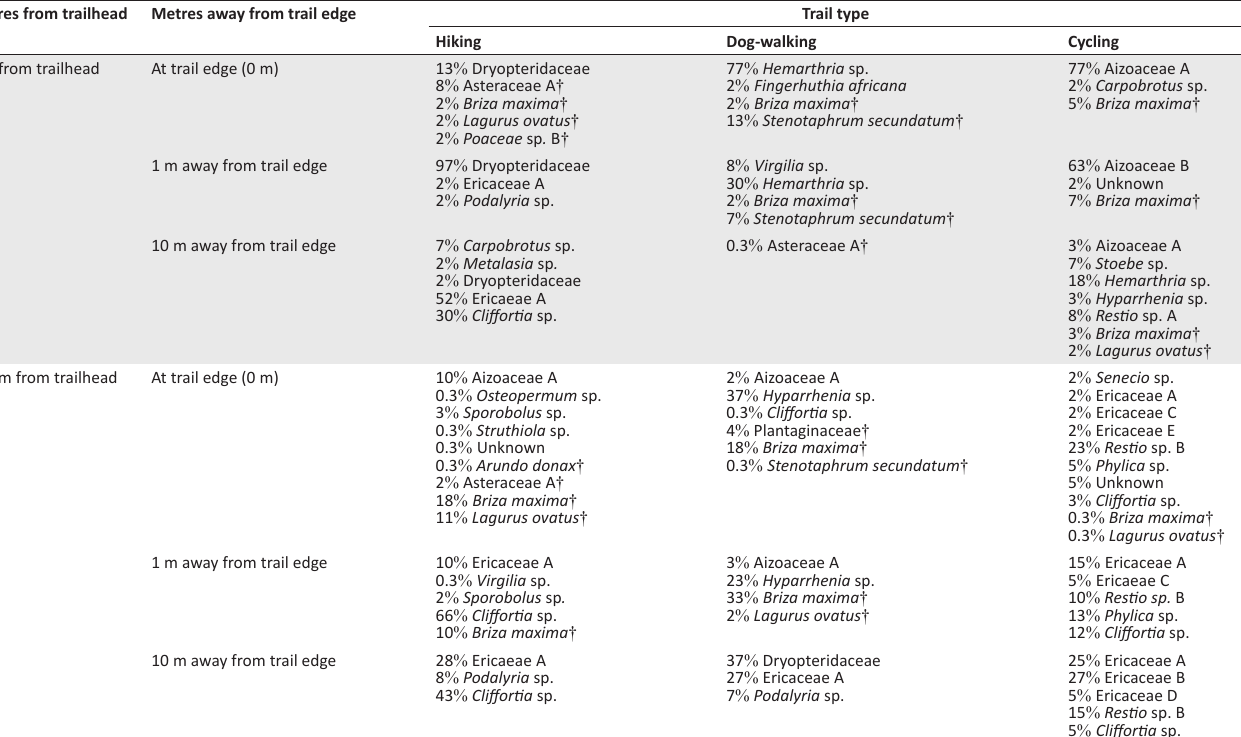
TABLE 2: The percentage of cover of plant species identified to family or genus level, averaged from three 1-metre2 quadrats used in the vegetation transects along the various trails in the Silvermine section of the Table Mountain National Park. Metres from trailhead Metres away from trail edge